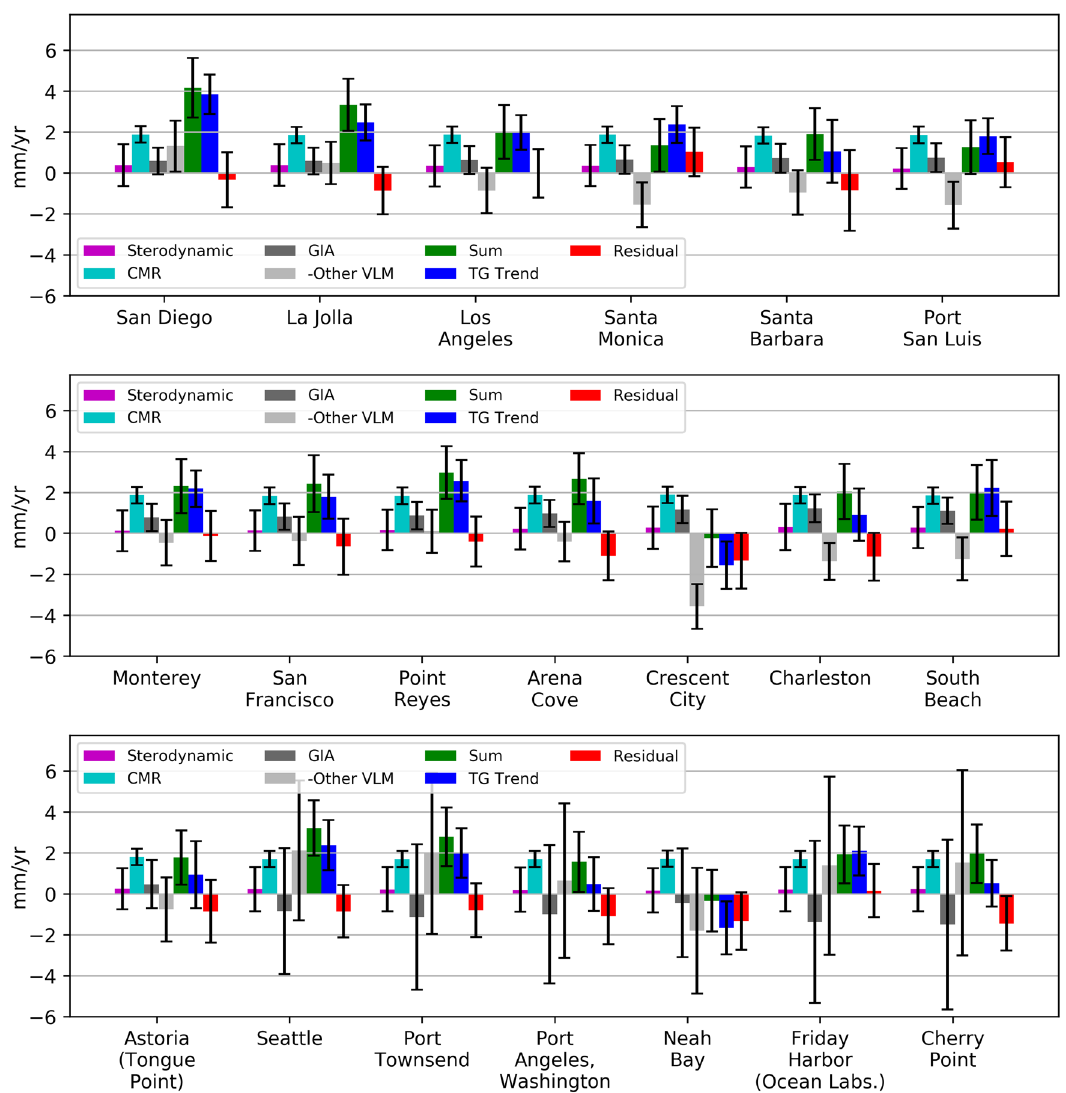
Fig. 7 West Coast sea level trends. Trend assessment from 1993 to 2018 for tide gauges along the U.S. west coast. Residuals are computed as the difference between the sum of the contemporary mass redistribution, sterodynamic effects, and GIA, and non-GIA vertical land motion components and the trend measured at the tide gauge. The vertical land motion component is inverted for interpretability. Uncertainty estimates represent two-standard